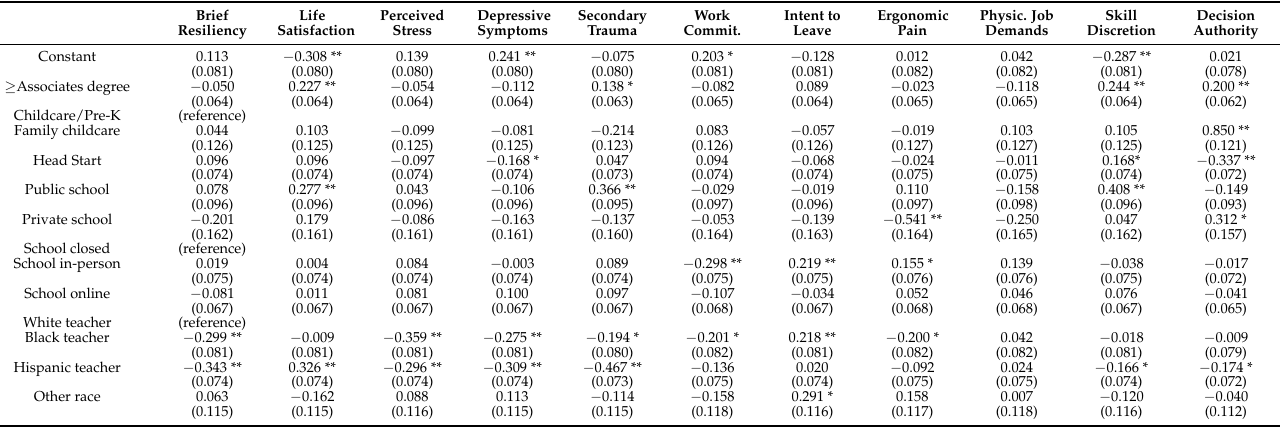
Table 4. Main effects regression of psychological, physical, and professional well-being by modality and teacher